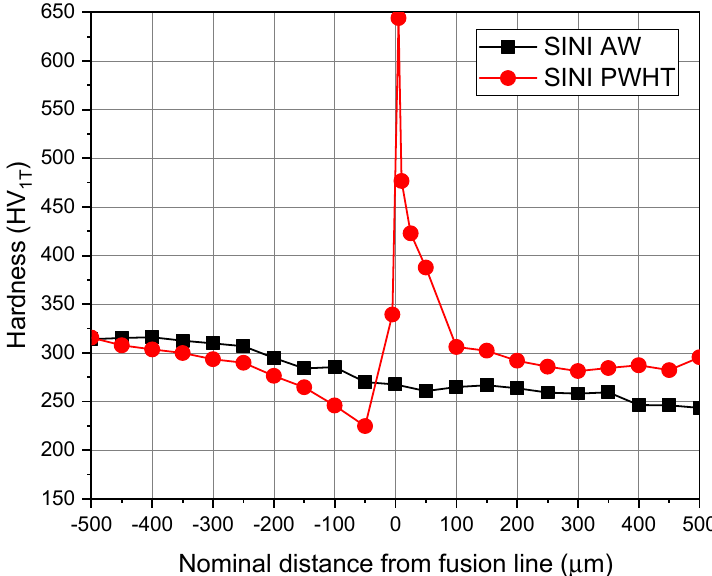
Figure 11. Comparison of the microhardness (350 mN) profiles of SINI AW and SINI PWHT at the LAS/Alloy 52 weld metal interface.